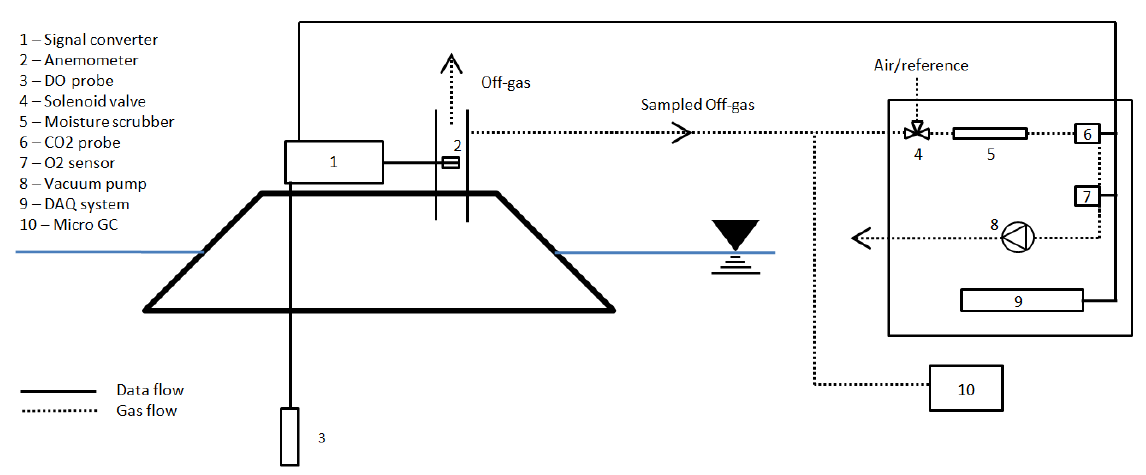
Figure 4. Scheme of the Off-gas analyzer [19].